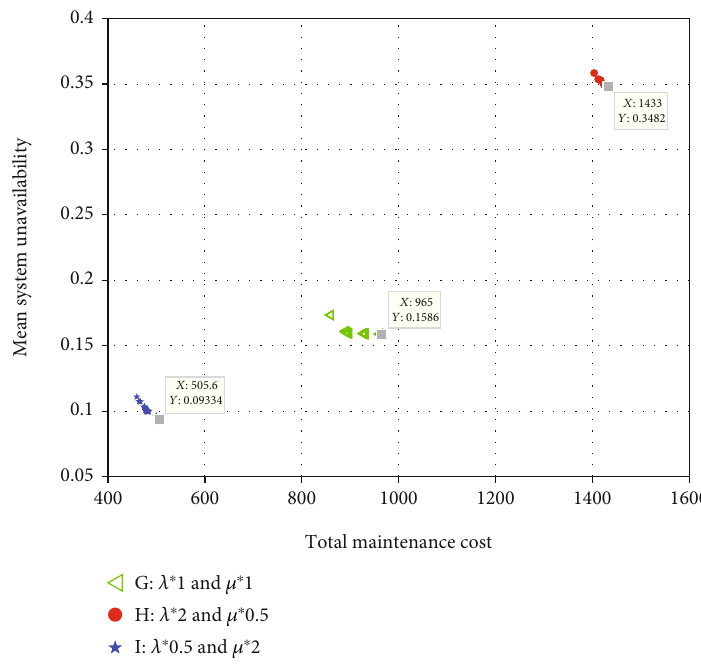
Figure 16: Pareto frontier for third-level human